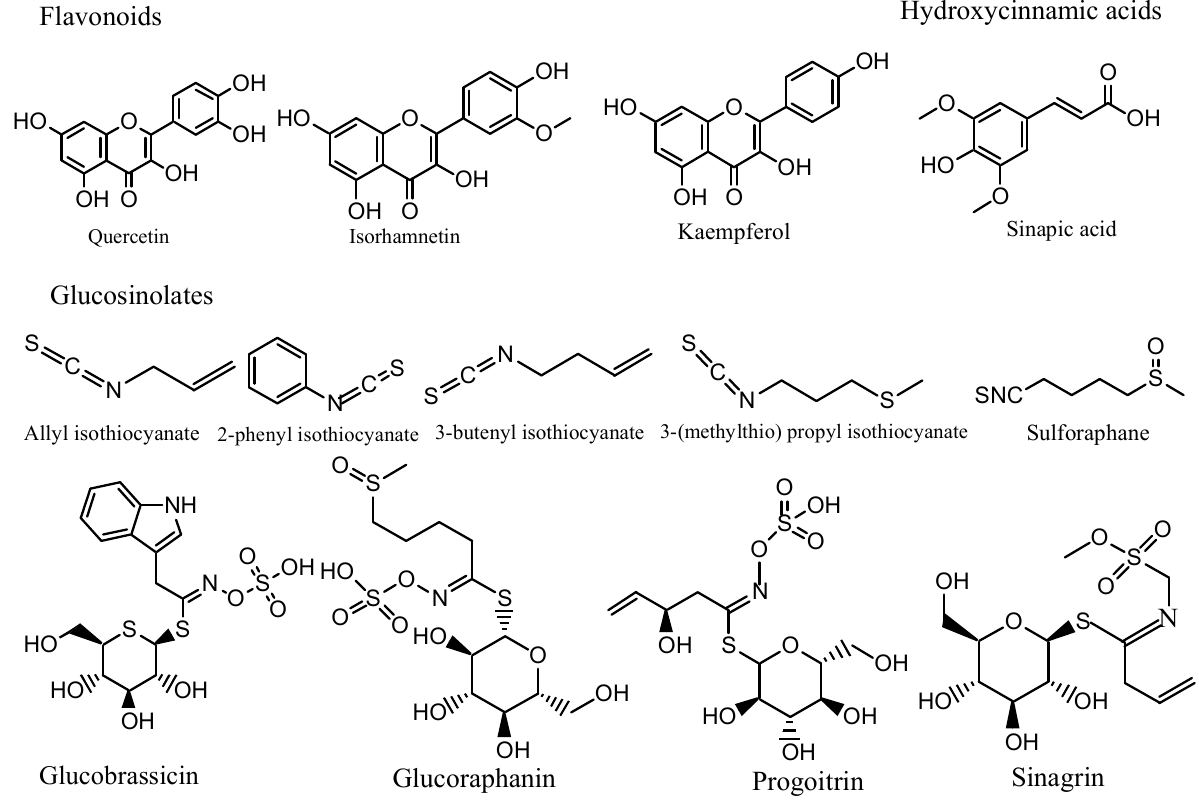
Figure 1. Molecular structures of the main bioactive compounds present in Brassica spp. seeds.